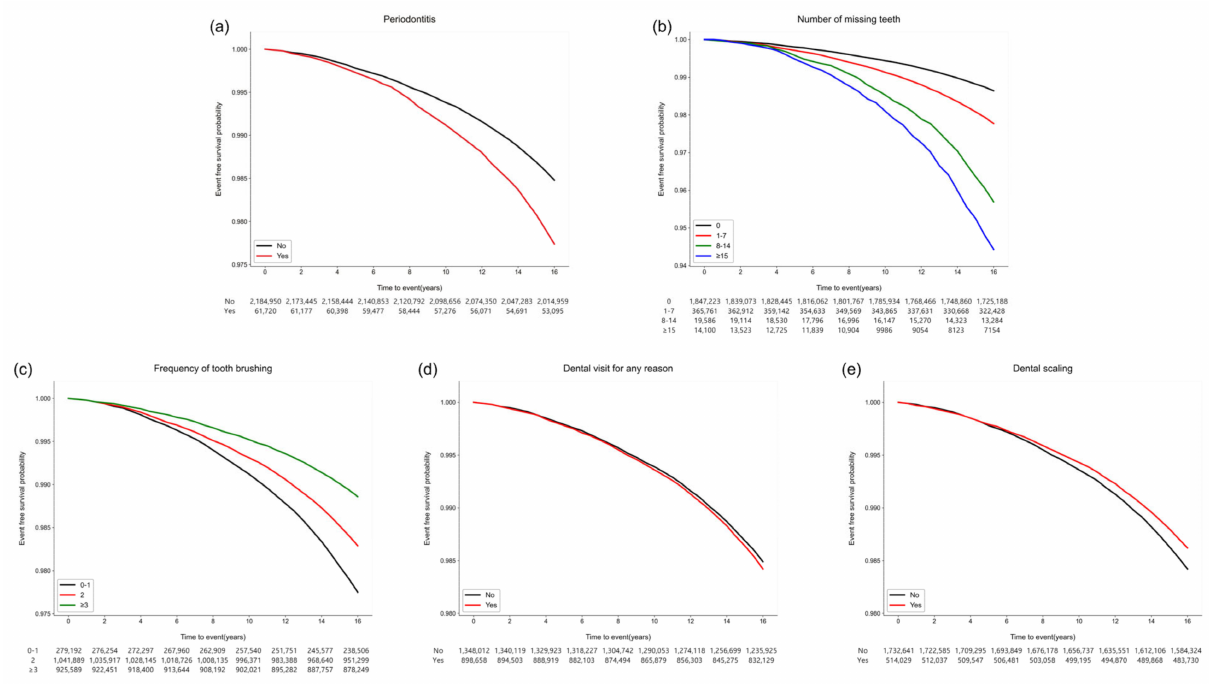
Figure 2. Kaplan–Meier survival curves for the occurrence of VTE according to oral health status and oral hygiene behaviors. ( a ) Periodontitis ( p < 0.001). ( b ) Number of missing teeth ( p < 0.001). ( c ) Frequency of tooth brushing (times/per day) ( p < 0.001). ( d ) Dental visit for any reason within